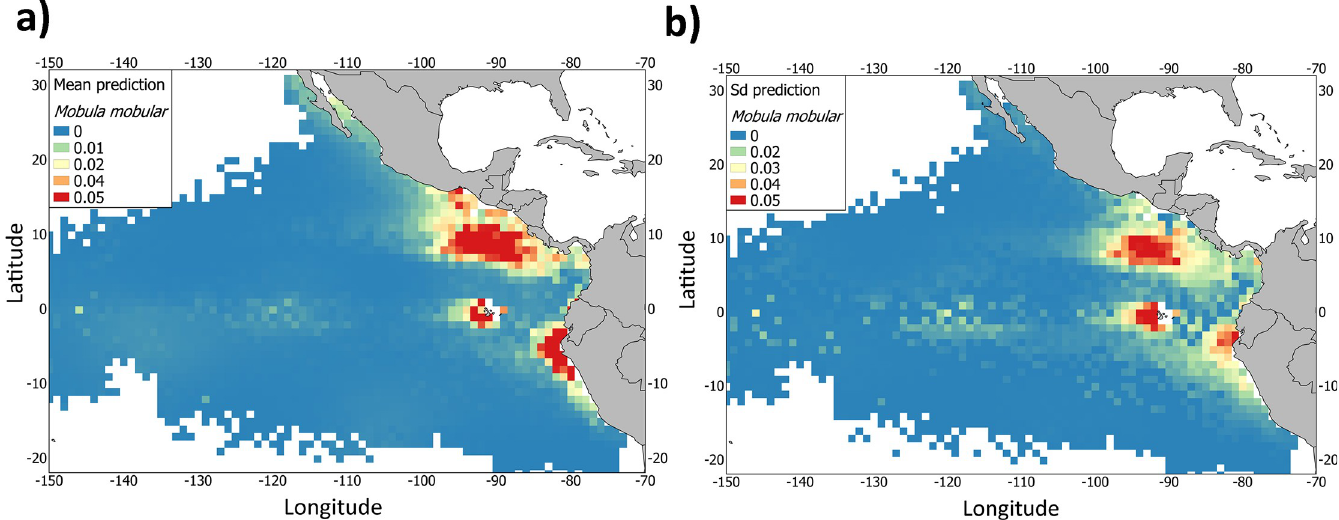
Fig 5. Mean prediction and standard deviation of the presence of Mobula mobular bycatch from the tropical tuna purse-seine fishery (2005–2015) in the eastern Pacific Ocean based on the most parsimonious model fit.